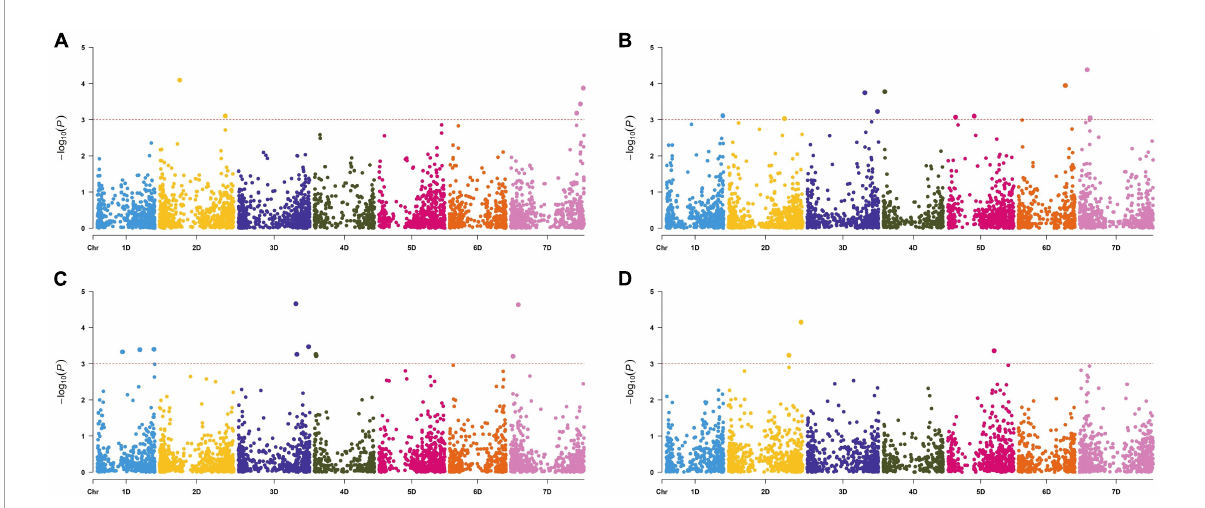
FIGURE3 Manhattan plots of marker-trait associations detected by the mixed linear model using 6,739 single nucleotide polymorphisms in 286 Aegilops tauschii accessions. Panels (A–D) represents marker-trait associations of disease index (A) , flowering time (B) , heading time (C) , and plant height (D) . The horizontal dashed line represents the significant threshold – log 10 ( P ) = 3.00.